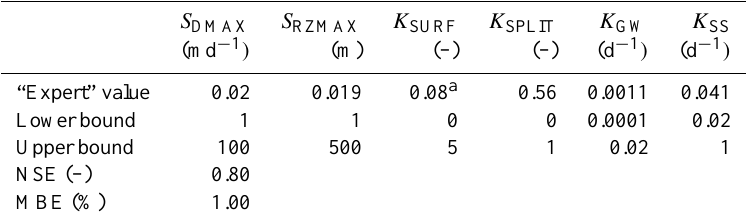
Table 3. Hydrological model parameters: bounds and performance metrics (baseline